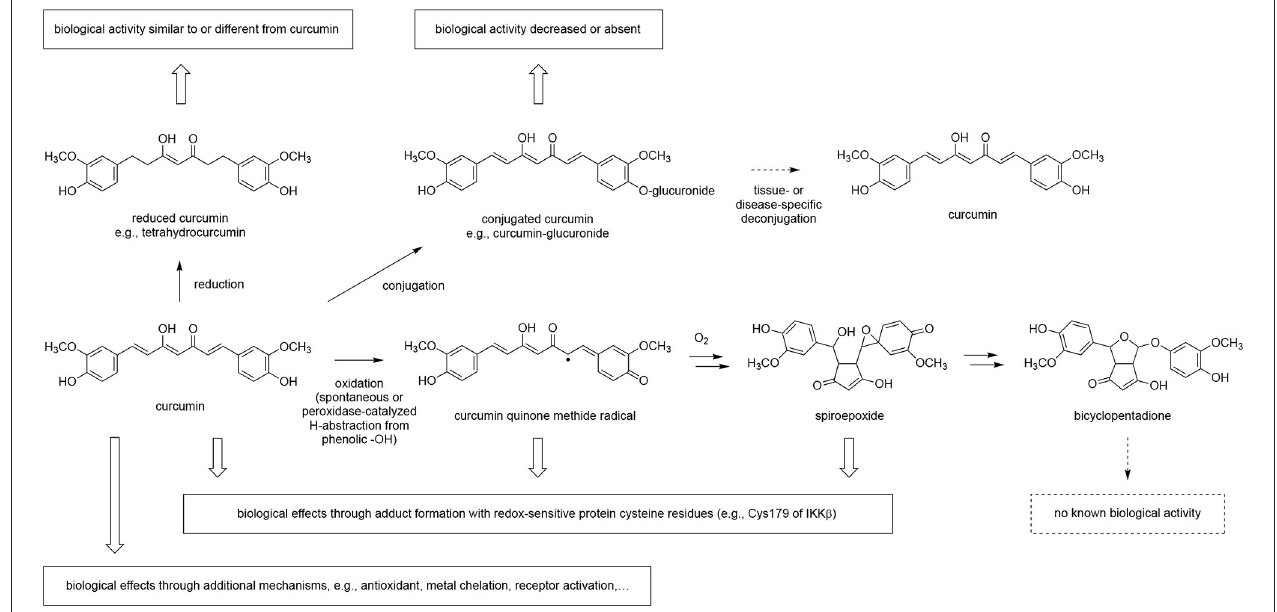
FIGURE 5 | Metabolism of curcumin and the effect on biological activity. Curcumin is reduced and conjugated in vivo as shown by the detection of the corresponding metabolites in plasma samples. Deconjugation of circulating and inactive curcumin-glucuronide by β -glucuronidase may contribute to a tissue- or disease-specific effect. Oxidation of curcumin is prominent in buffer and in cultured cells but awaits to be proven in vivo . Adduction of curcumin to protein has been described, and at least in part depends on oxidation of curcumin to a quinone methide or other electrophilic oxidation product, i.e., spiroepoxide, that target redox-sensitive cysteine residues and soluble thiols like glutathione. The quinone methide radical and spiroepoxide are unstable intermediates in the oxidation of curcumin to the stable end-product, bicyclopentadione. Curcumin also exerts biological effects through mechanisms not involving metabolic